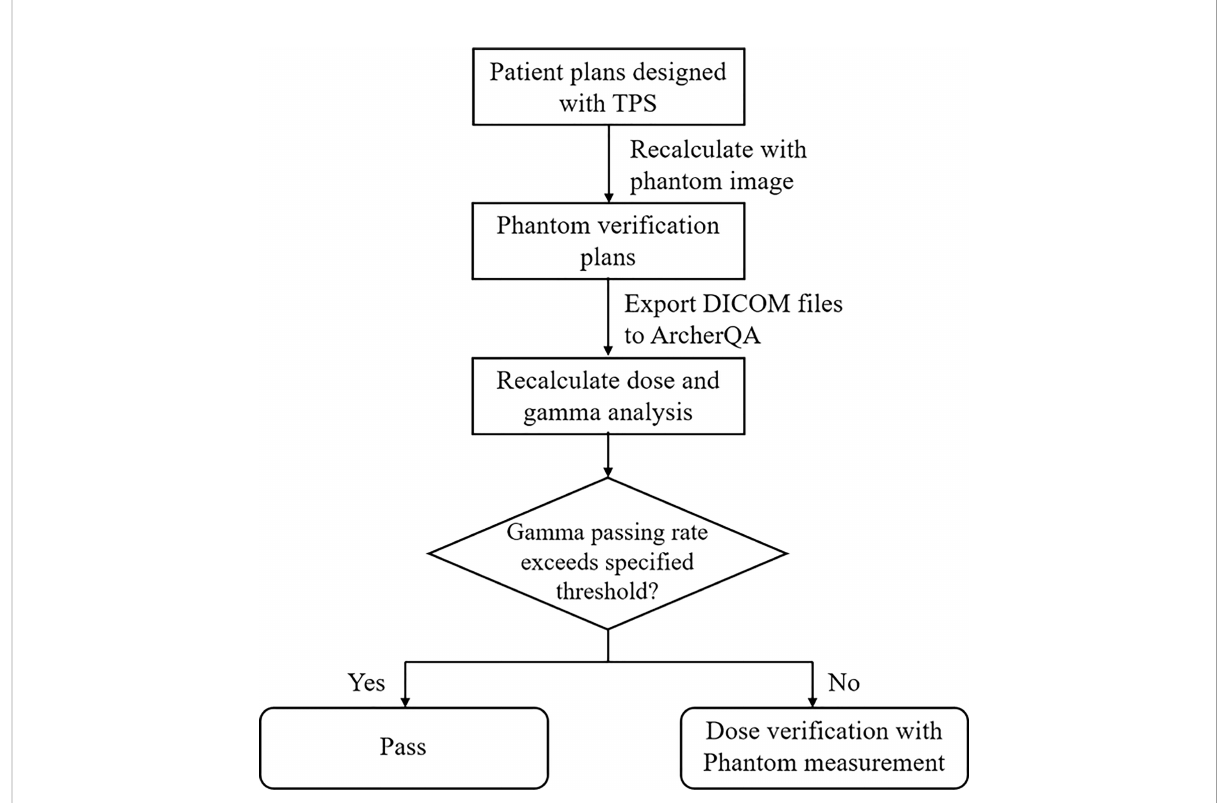
FIGURE 1 The work fl ow of pre-screening treatment plans for patient-speci fi c QA measurement with ArcherQA computed with the TPS and MC. If the gamma passing rate of a plan is higher than a speci fi c threshold, it means that the plan is acceptable (pass) for treatment; otherwise, further measurement is needed to validate the